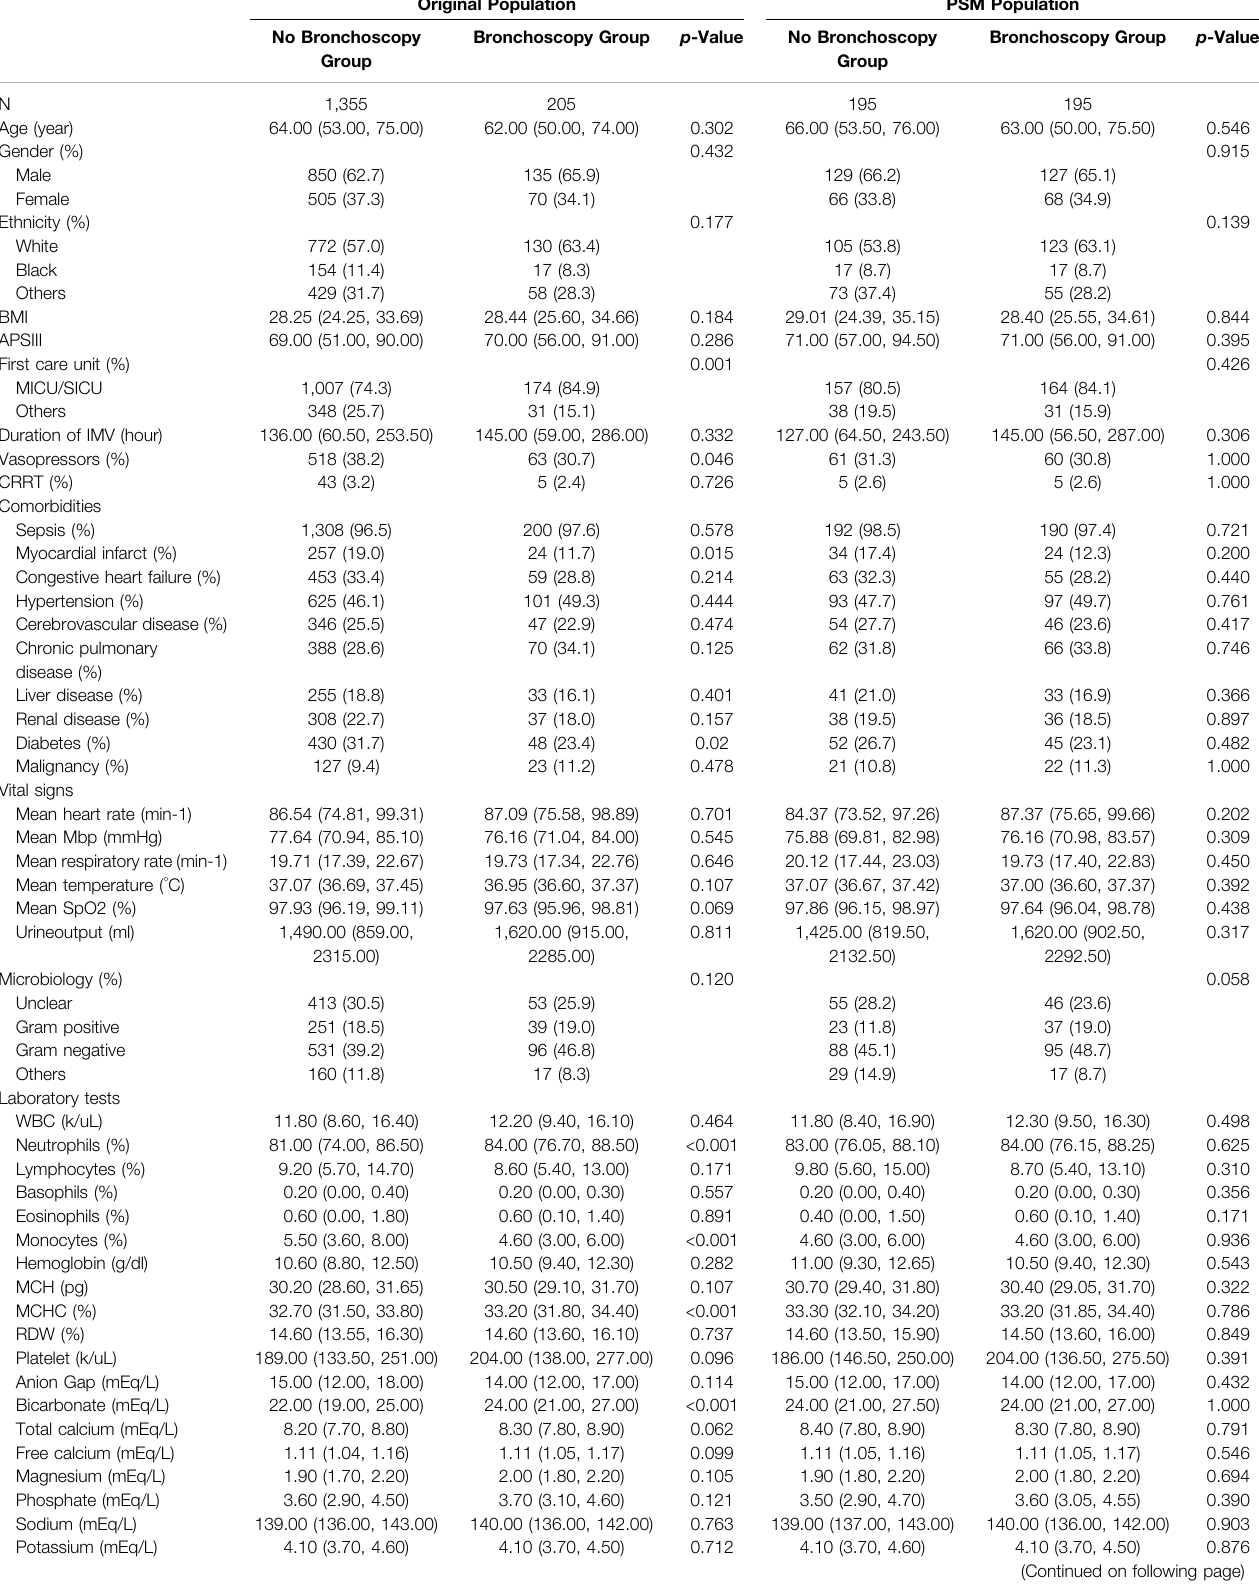
TABLE 1 | Baseline characteristics of original